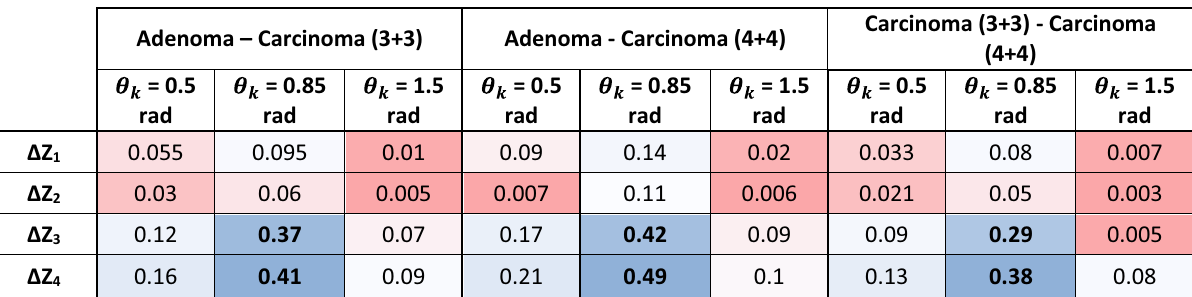
Adenoma – Carcinoma